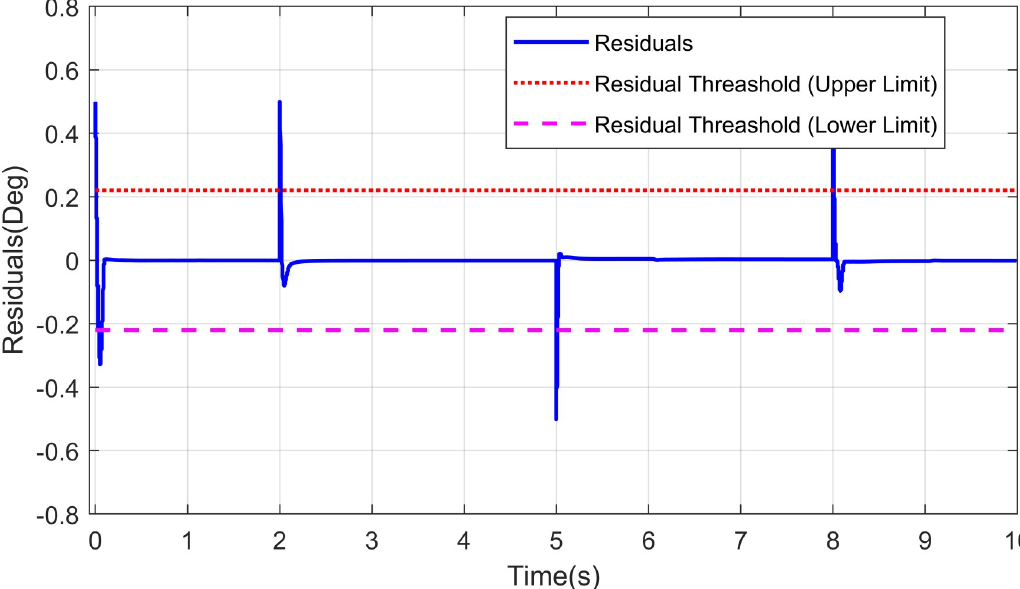
Fig 15. Residuals for fault profile in robot manipulator joint.